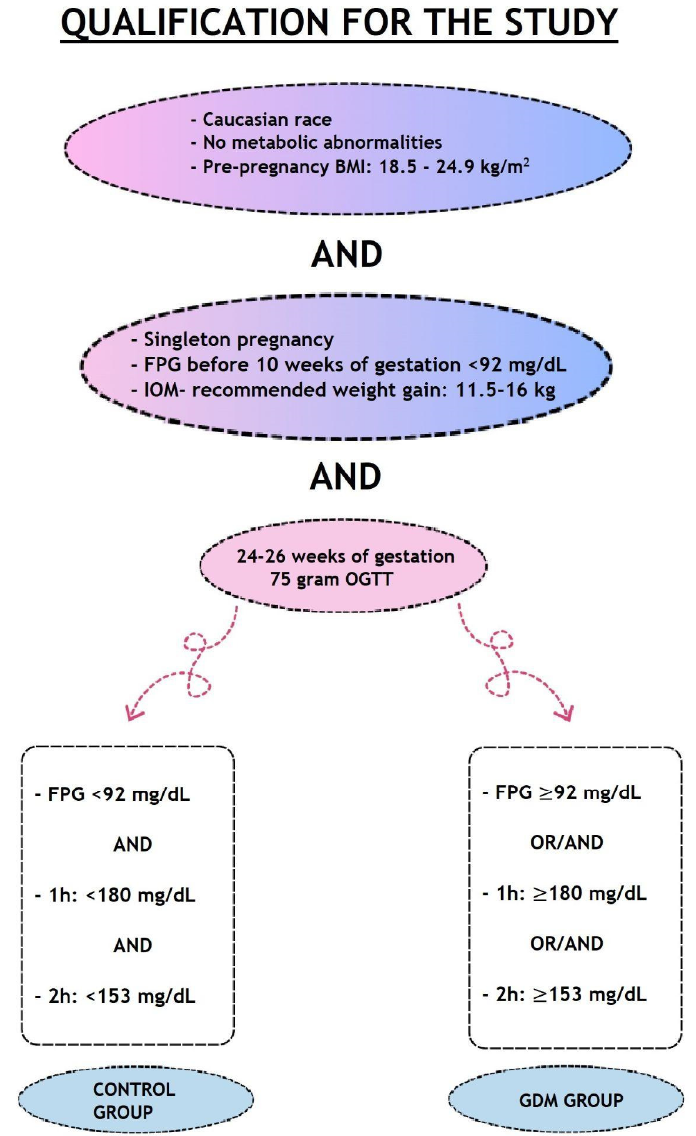
Figure 1. Qualification for the Figure 1. Quali fi cation for the study.